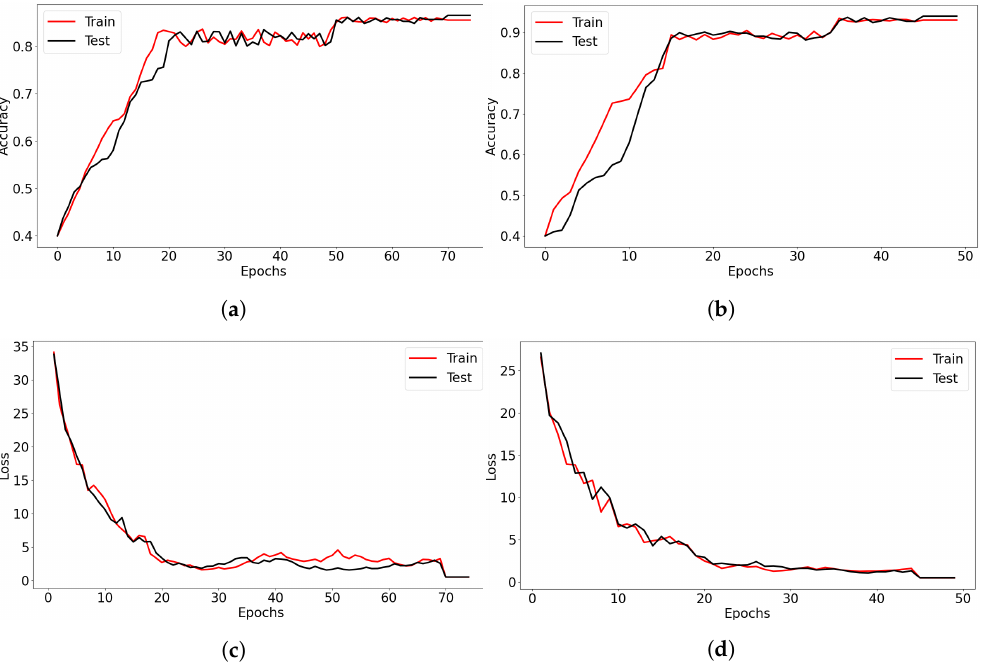
Figure 5. Selected learning parameters. ( a ) Learning accuracy for input without the tennis racket. ( b ) Learning accuracy for input with the tennis racket. ( c ) Loss value for input without the tennis racket. ( d ) Loss value for input with the tennis